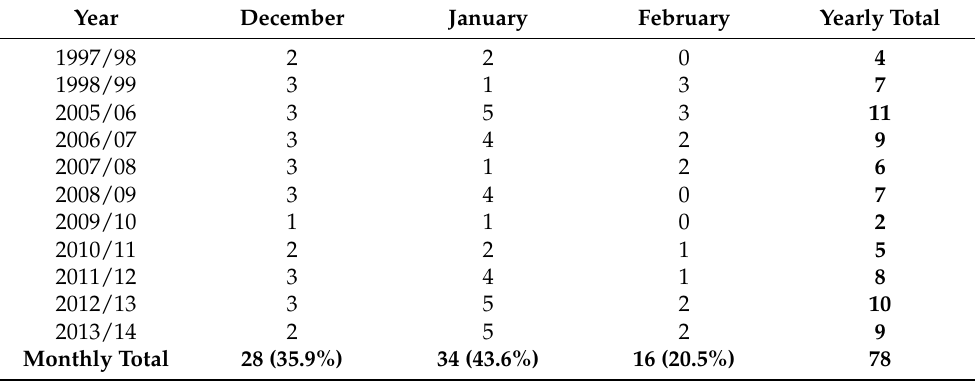
Table 1. Monthly breakdown of recorded clippers over the 11 meteorological winters used for this study. Bold face numbers represent monthly or yearly totals and the numbers in parentheses show the percentage of clippers relative to the total number of clippers identified in the